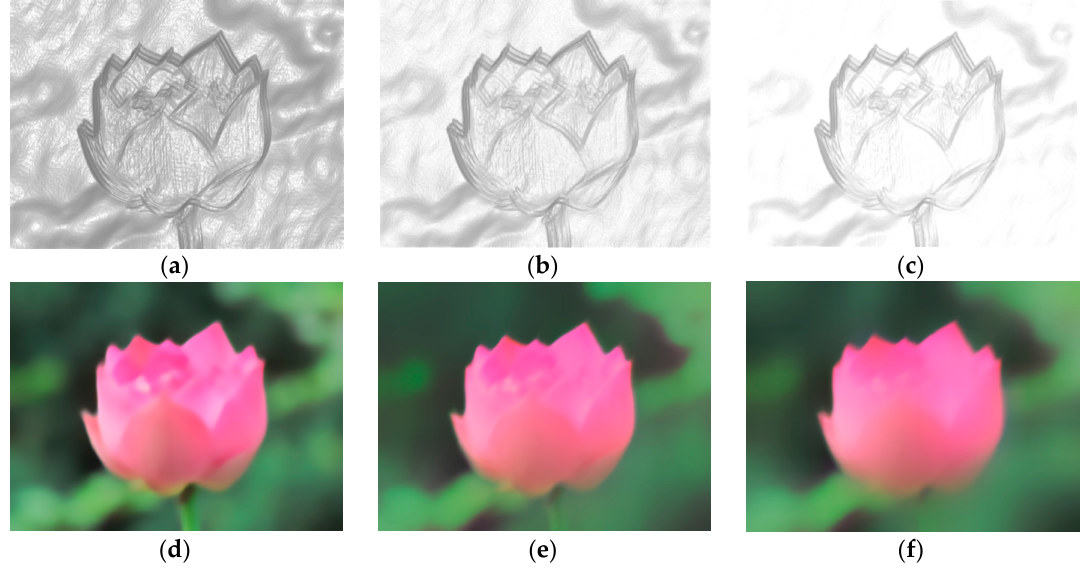
Figure 4. The influence of α s on extracted salient structure. ( a ) s = 0.2; ( b ) s = 0.5; ( c ) s = 0.8; ( d ) extracted salient structure relevant to s = 0.2; ( e ) extracted salient structure relevant to s = 0.5; and ( f ) extracted salient structure relevant to s = 0.8.